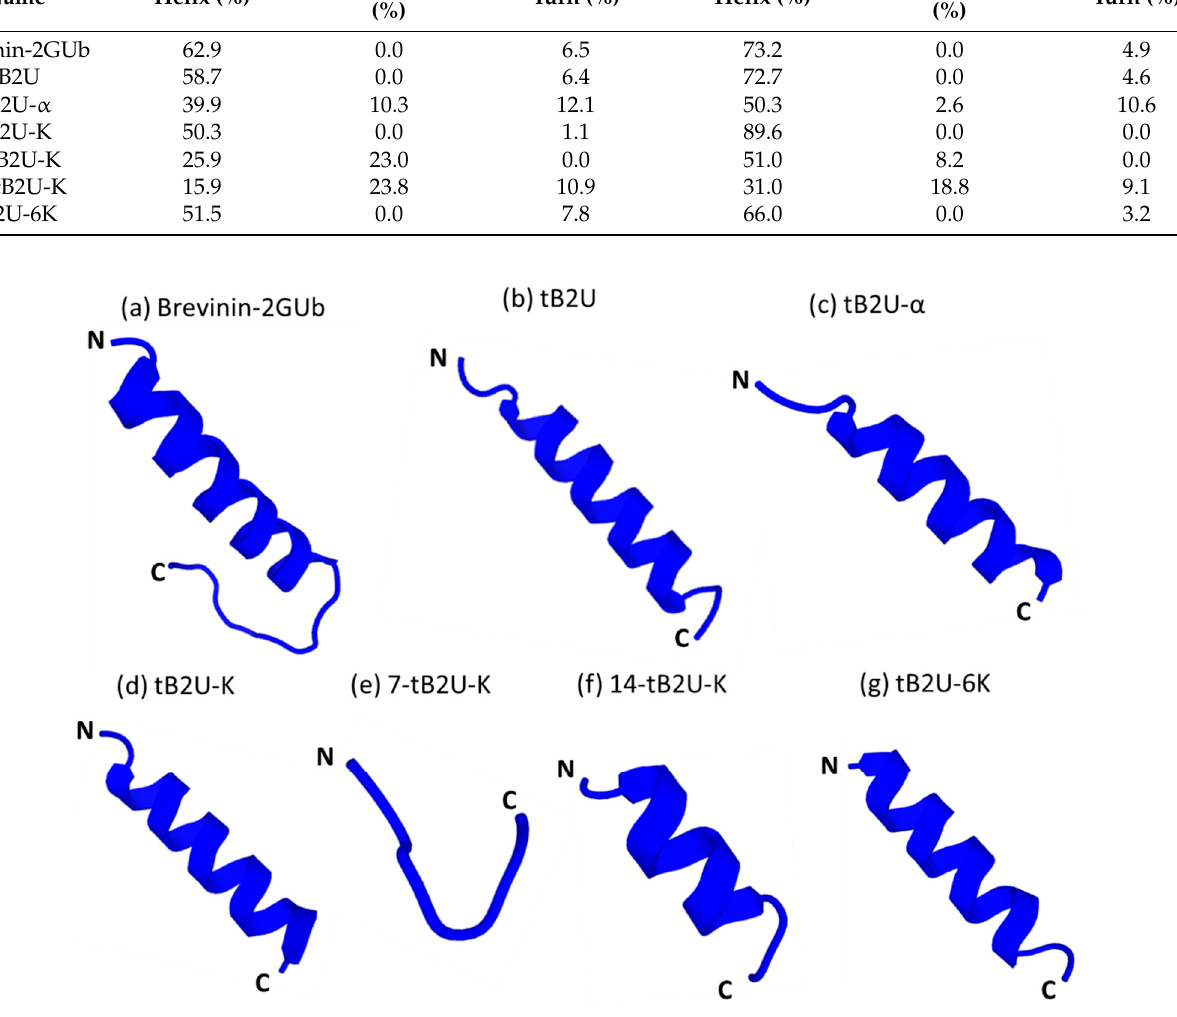
Figure 2. The 3D models of ( a ) Brevinin-2GUb, ( b ) tB2U, ( c ) tB2U- α , ( d ) tB2U-K, ( e ) 14-tB2U-K, ( f ) 7-tB2U-K, and ( g ) tB2U-6K predicted by the Pep-fold3.